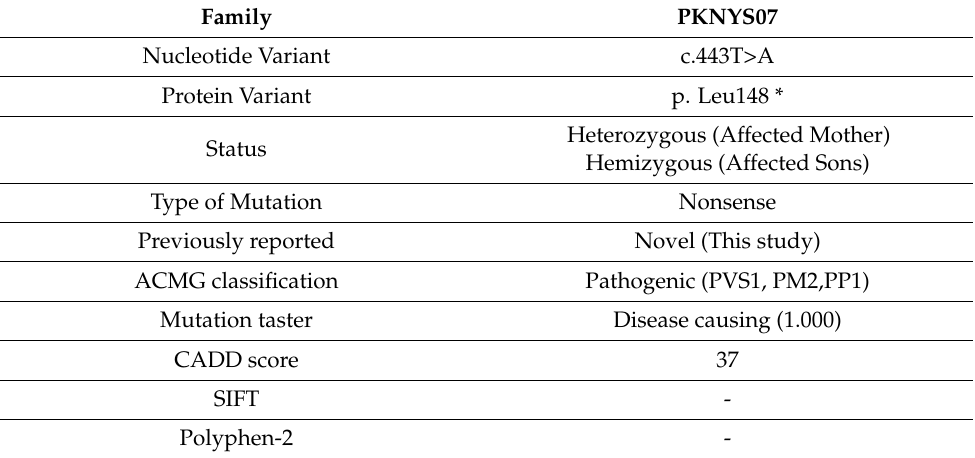
Table 2. Mutation identified in this